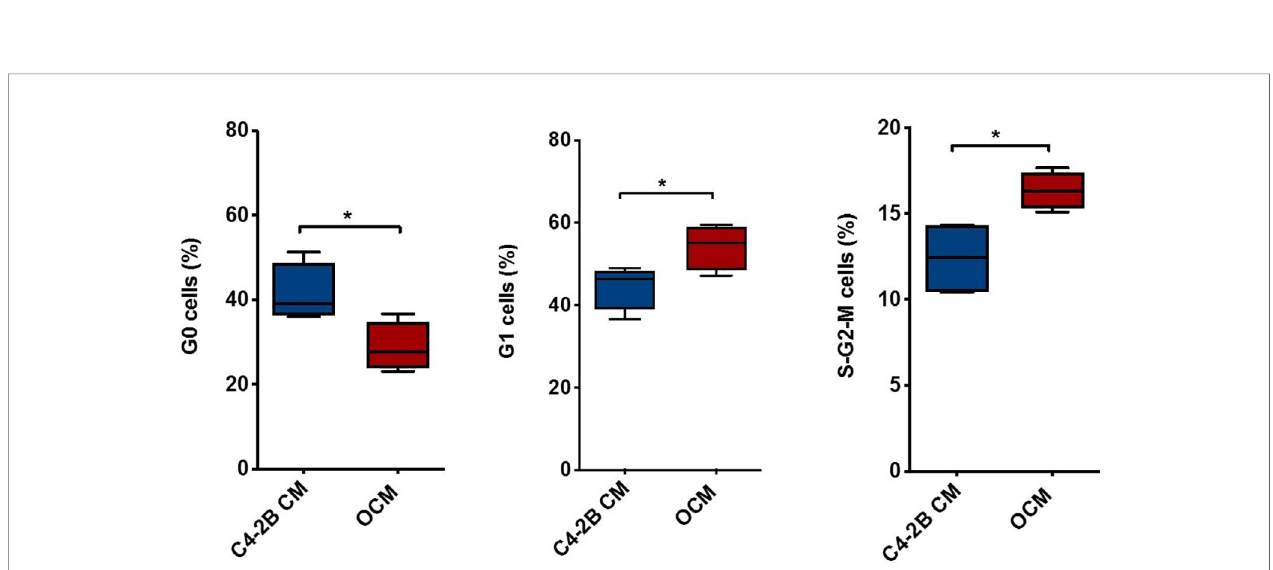
FIGURE 4 | Combination of PI and Ki-67 staining in C4-2B FR cells treated with OCM. Schematic representation of C4-2B cells percentage in G0, G1, and S-G2-M phases after OCM treatment with average value (bar). Cytometry pro fi les are representative of data from 4 different experiments. * p < 0.05.